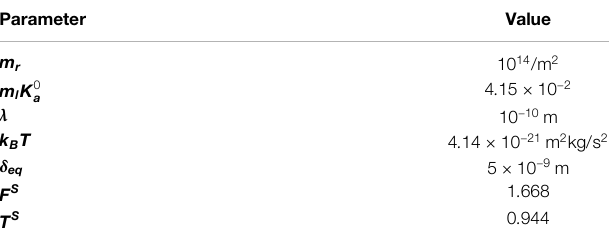
TABLE 2 | Parameters used for the calculation of cell deposition probability using the Decuzzi algorithm (Sohrabi et al., 2014).